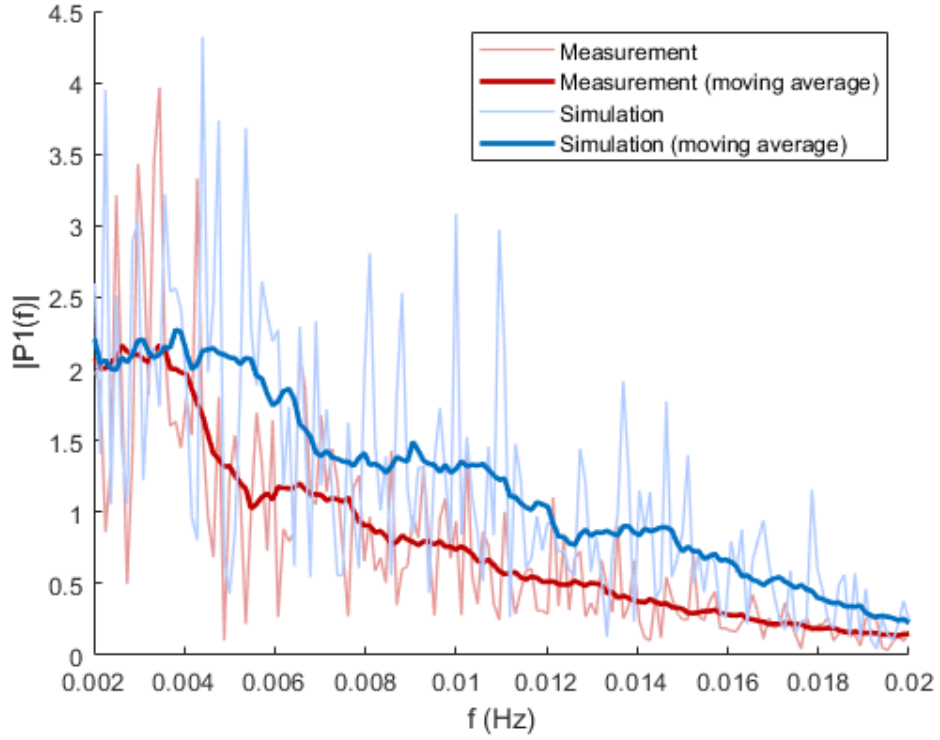
Figure 15. FFT analysis of combustion chamber temperature at 2.9 kW input power.